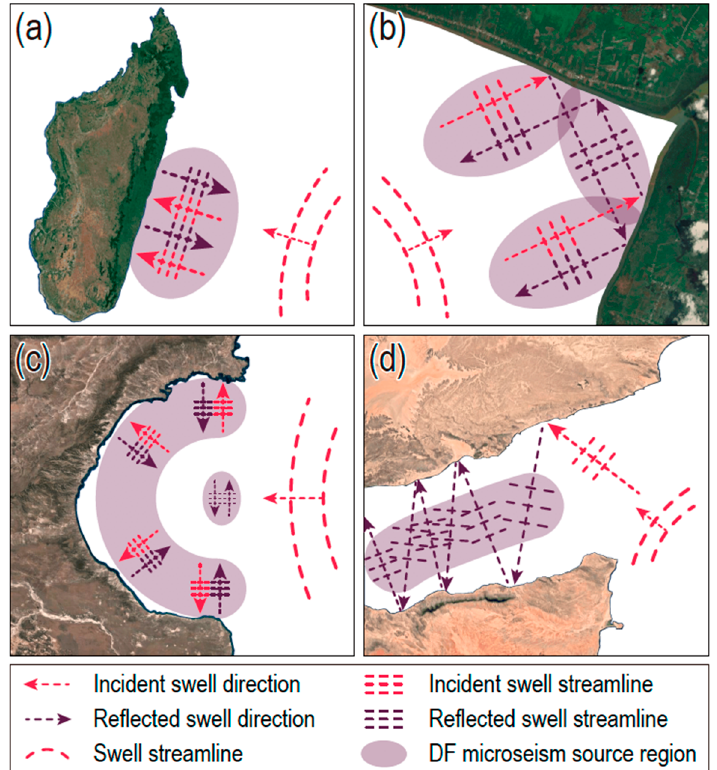
Figure 7. Examples of coastline geometries that facilitate the generation of dispersive DF microseisms, including ( a ) straight coast, ( b ) rectangular coast, ( c ) bay, and ( d ) channel. In all cases, the coast provides opportunities for interference between incident and reflected ocean waves with similar periods. Landscape images were downloaded from Google Maps.